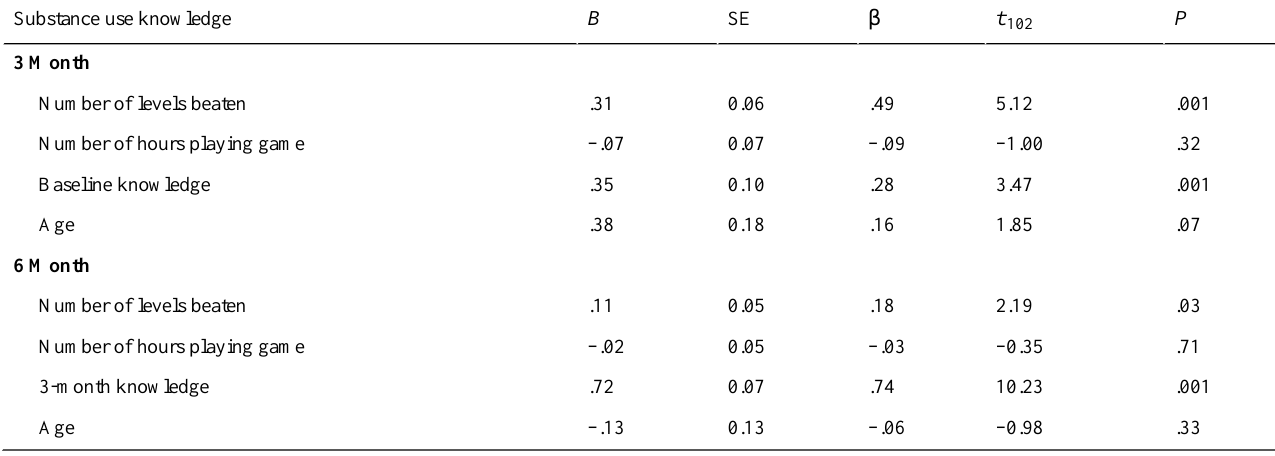
Table 3. Association of game play with gains in substance use